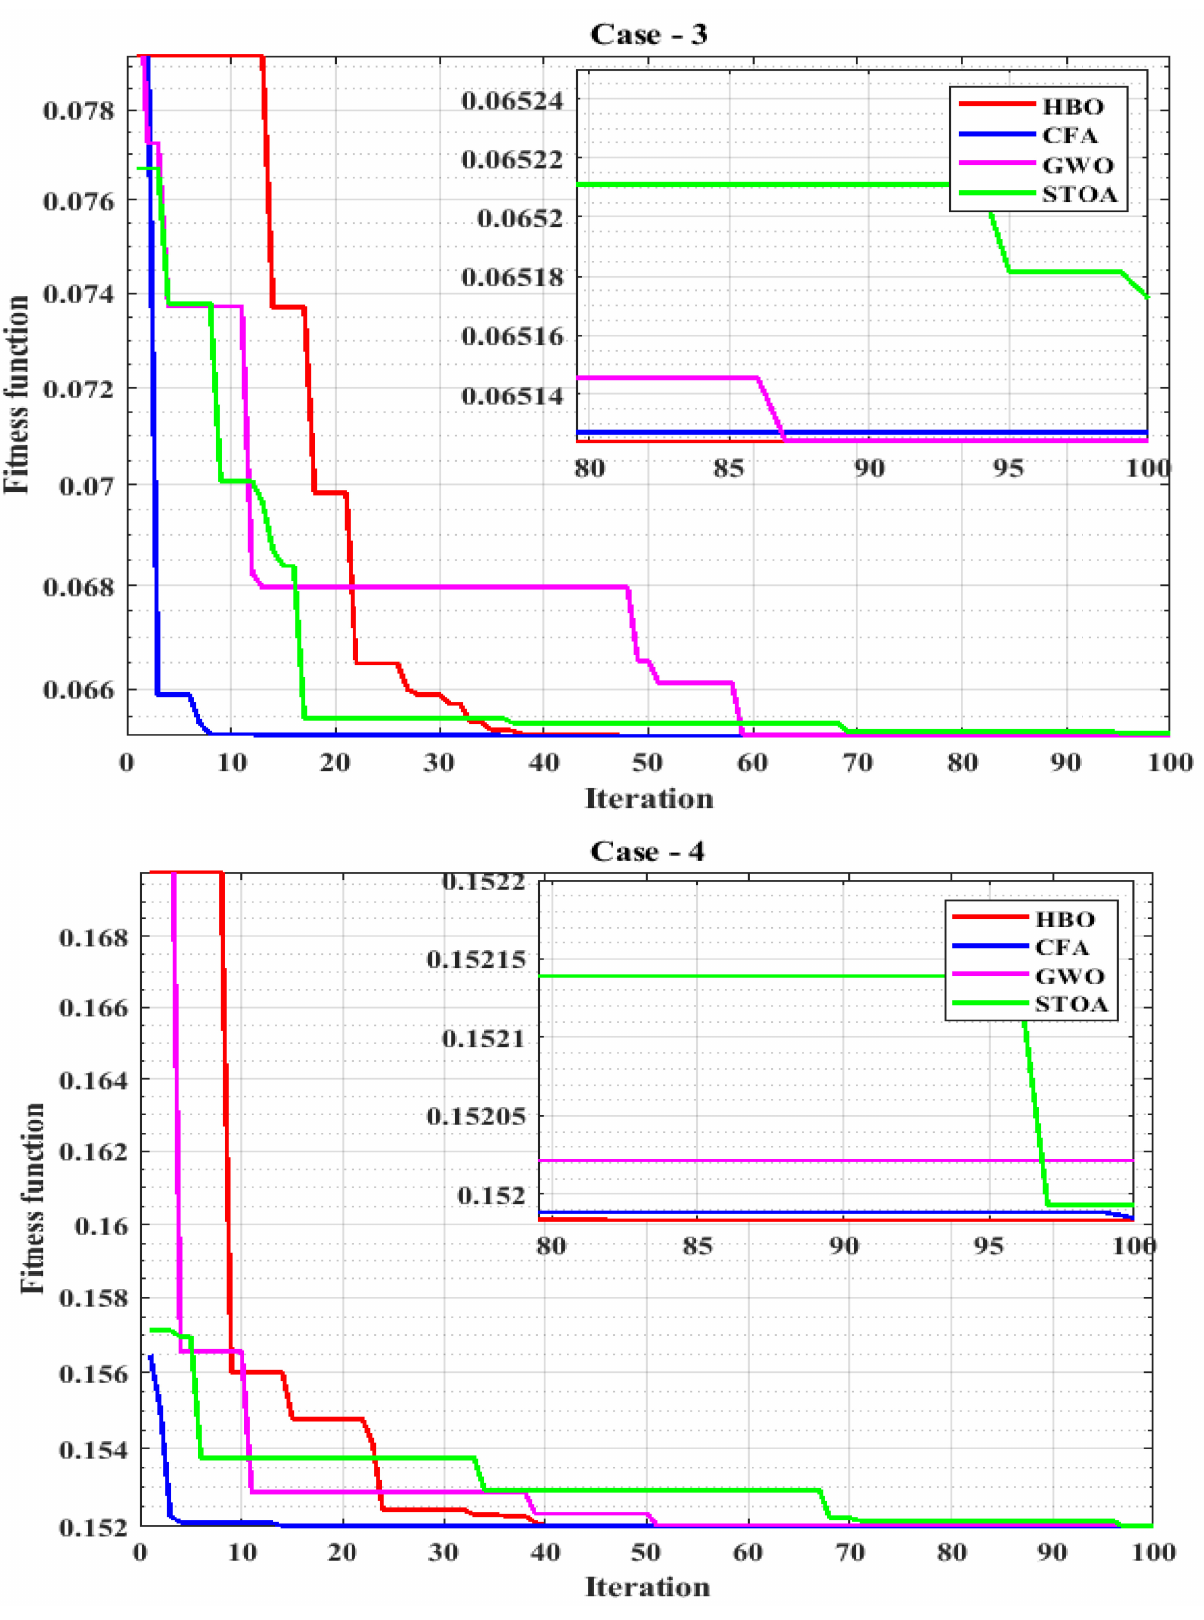
Figure 9. The Convergence curves for 100 iterations using HBO, CFA, GWO, and STOA methods: case-1: PV/WT/Biomass/Bat system, case-2: PV/Biomass/Bat system, case-3: WT/Biomass/Bat system, case-4: PV/WT/ Bat